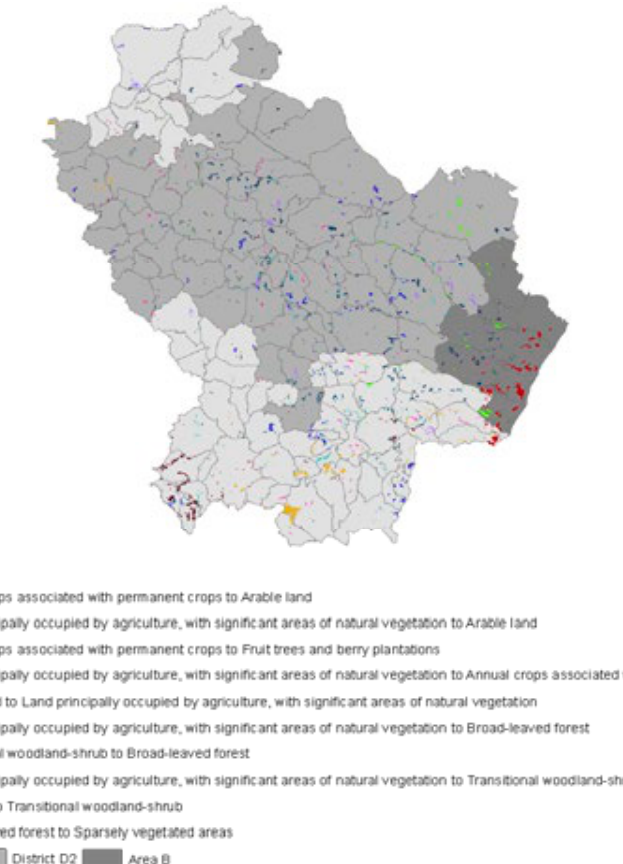
Figure 5. Land use change map: “Future CAP”